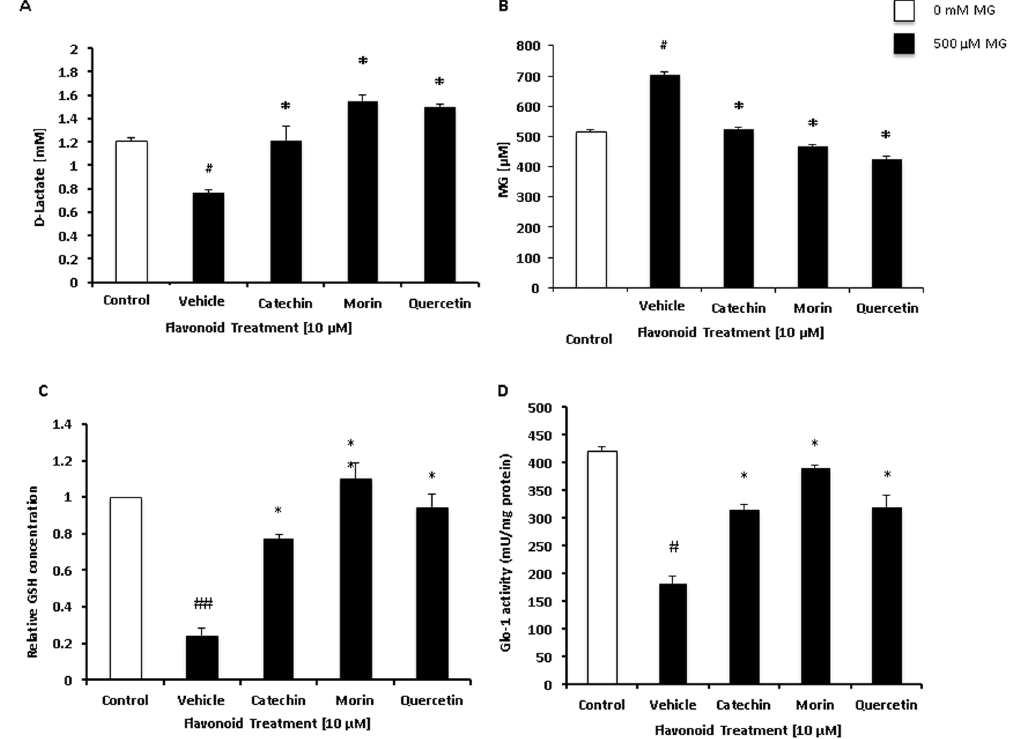
Figure 2. ( A ) Analysis of D-lactate release into extracellular space from neurons treated with MG (500 μ M) and flavonoids (10 µ M). Control = no MG, Vehicle = only MG. Results are means + / − SEM of multiple independent experiments performed in triplicate. # P < 0.05 (vs Control), * P < 0.05 (vs Vehicle). ( B ) Concentration of MG ( µ M/mL) in extracellular space was determined in cerebellar neurons treated with MG (500 μ M) and flavonoids (10 µ M). Values are means + / − standard error of samples performed in triplicate from several independent experiments. # P < 0.05 (vs Control), * P < 0.05 (vs Vehicle). ( C ) Concentration of GSH in cellular lysates was determined in cerebellar neurons treated with MG (500 µ M) and flavonoids (10 µ M). Values are means + / − standard error of samples performed in triplicate from several independent experiments. ## P < 0.01 (vs Control), * P < 0.05 (vs Vehicle), ** P < 0.01 (vs Vehicle). ( D ) Glyoxalase 1 activity was determined in cerebellar neurons treated with MG (500 µ M) and flavonoids (10 µ M). Values are means + / − standard error of samples performed in triplicate from several independent experiments. # P < 0.05 (vs Control), * P < 0.05 (vs